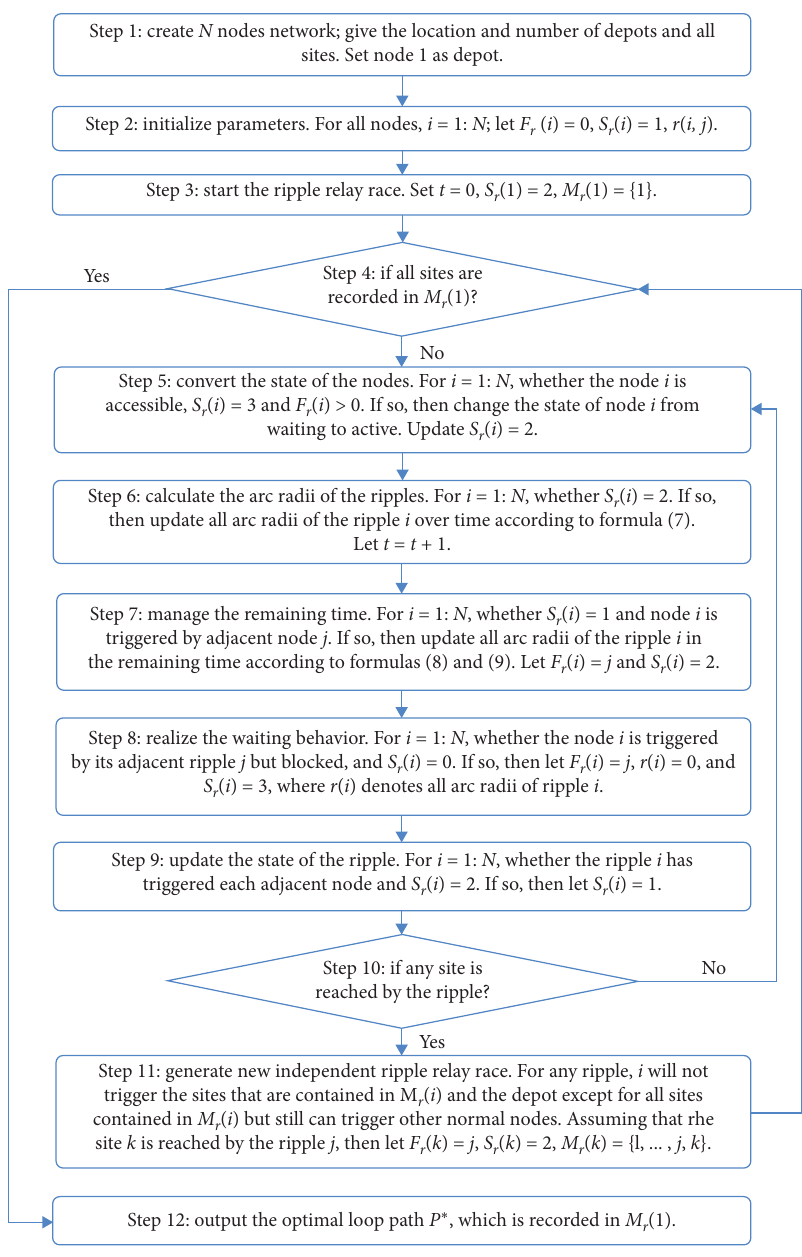
Figure 4: The flowchart of the FRSA based on the CEPO